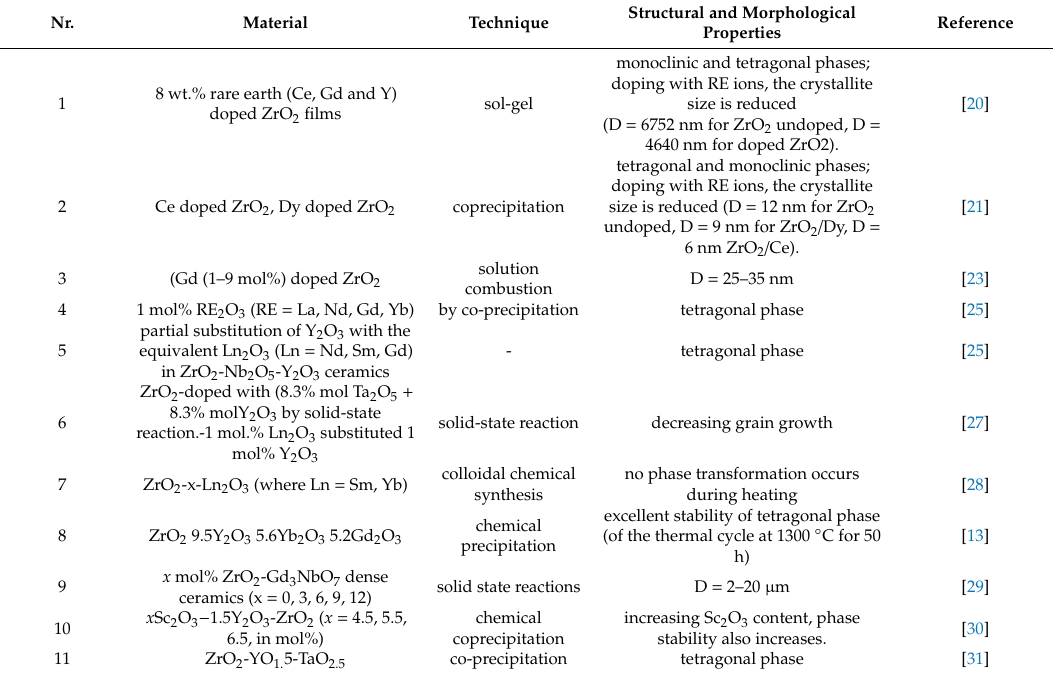
Table 3. The structural and morphological properties of the di ff erent materials based on ZrO 2 doped with rare earth oxides.